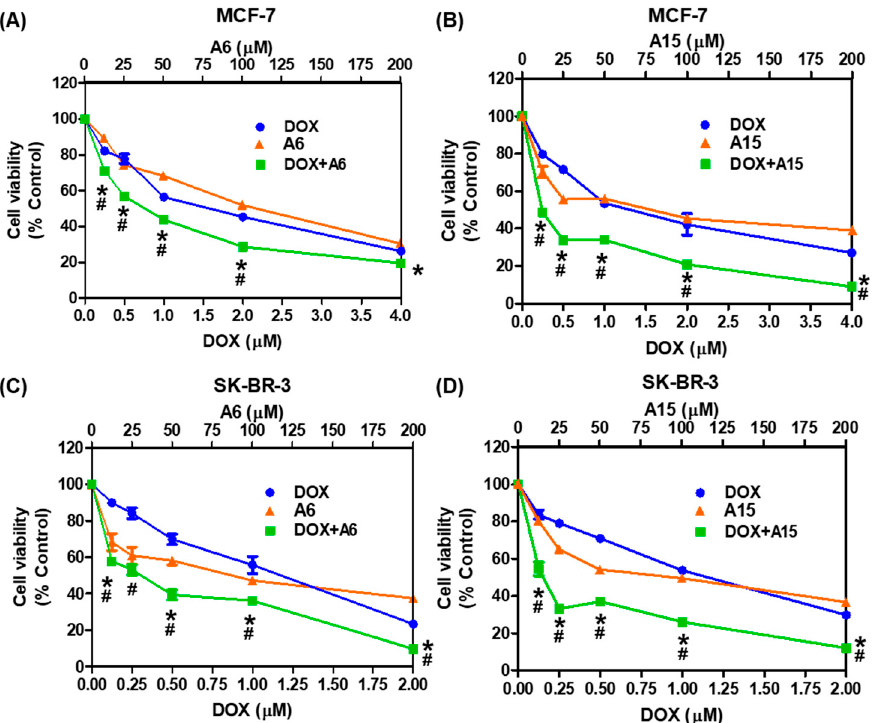
Figure 10. Cytotoxic effects of A6 or A15 alone or in combination with DOX on MCF-7 and SK-BR-3 cells. ( A , B ) MCF-7 and ( C , D ) SK-BR-3 cells were exposed to the indicated concentrations of A6 or A15 alone or in combination with DOX at fixed ratios for 48 h, as illustrated in Figure 9. Control cells were treated with the media containing 0.4% DMSO instead. The IC 50 values of A6 and A15 in both cell types, DOX in MCF-7 cells, and DOX in SK-BR-3 cells are set at 50, 1.0, and 0.5 μ M, respectively. Cell viability was determined by MTT assay. Data are displayed as mean ± SEM from three independent experiments. # p < 0.05 and * p < 0.05 vs. DOX-treated cells and A6 - or A15 -treated cells, respectively.